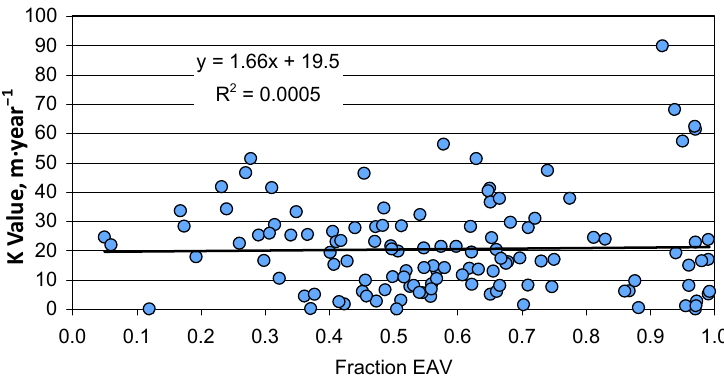
Figure 8. The dependence of the rate coefficient on the fraction EAV in SAV–EAV (submerged aquatic vegetation–emergent aquatic vegetation) stormwater wetlands.